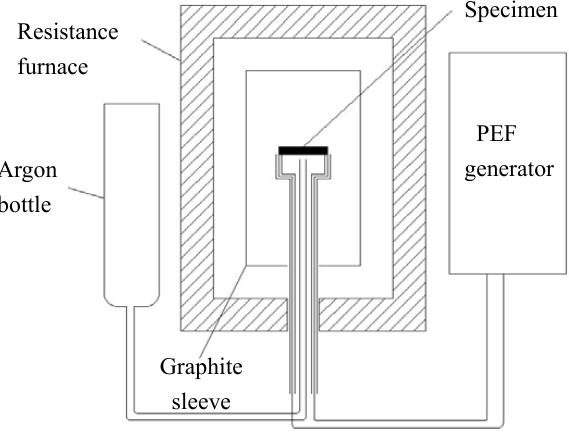
Figure 1. Schematic of experimental